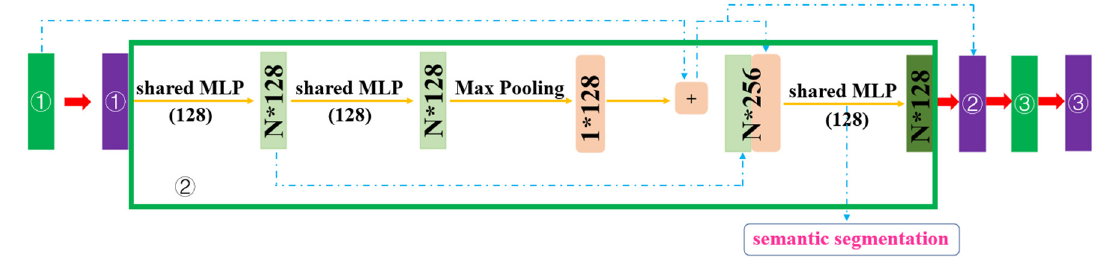
Figure 4. Illustration of the structure of the point feature extraction module.